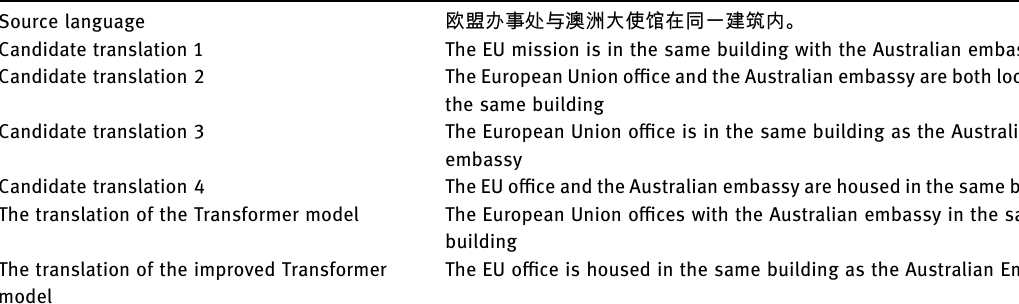
Table 3: Translation example 2 Source